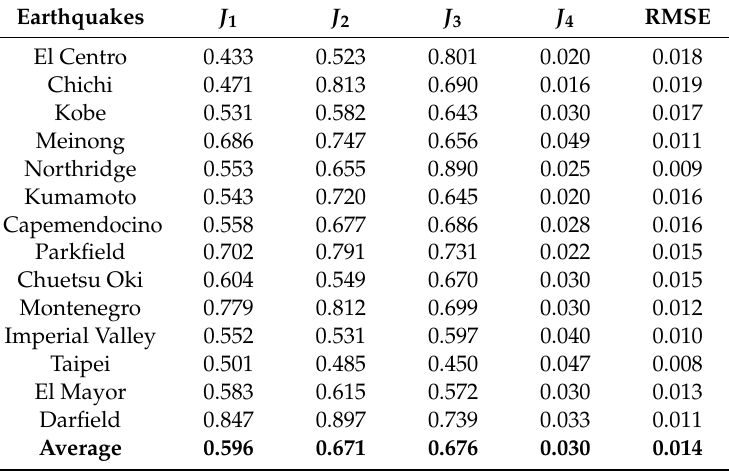
Table 4. Seismic control performance of the